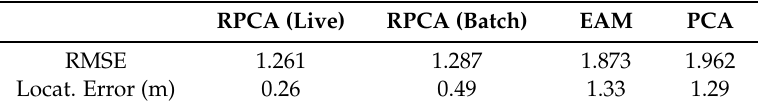
Table 1. Numeric results for a one-person-scenario.